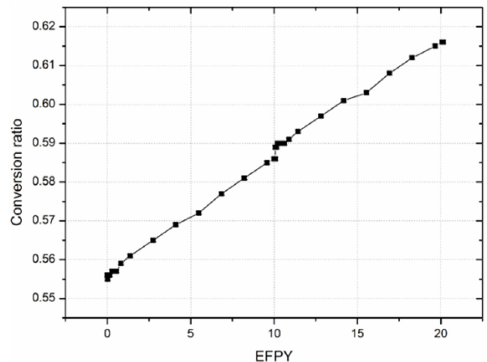
Figure 10. Conversion ratio of the KAIST MMR core.